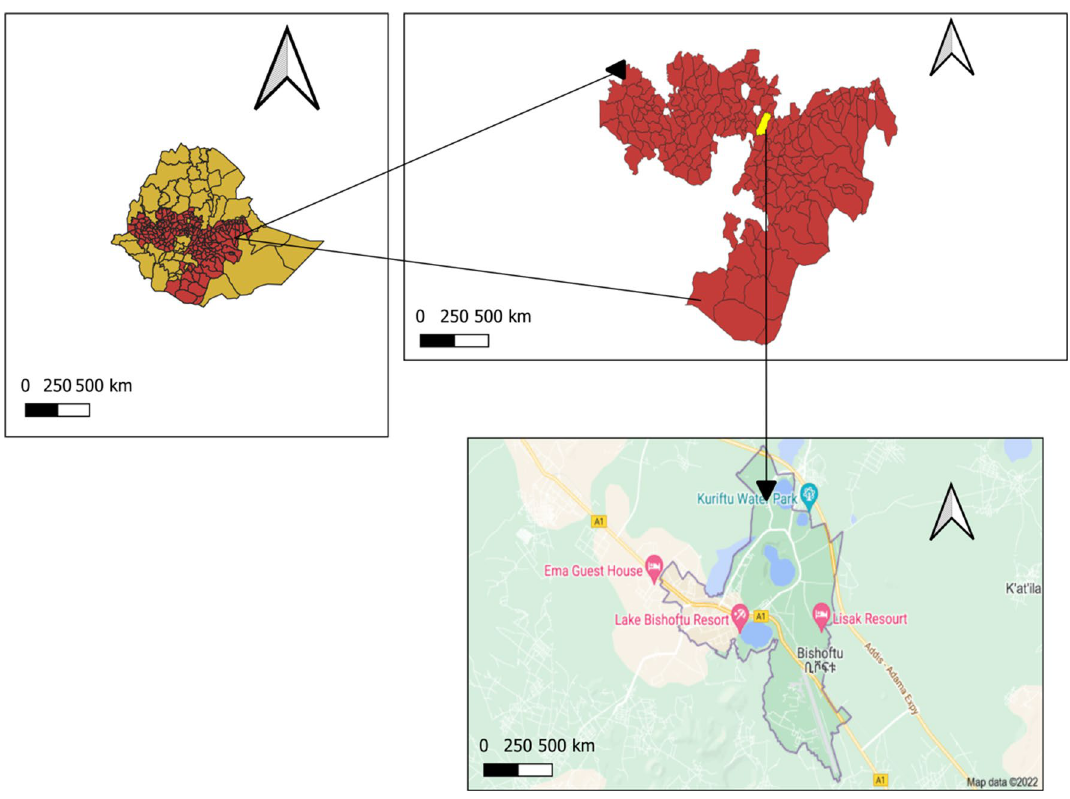
Fig. 1 Location Map of Bishoftu town,